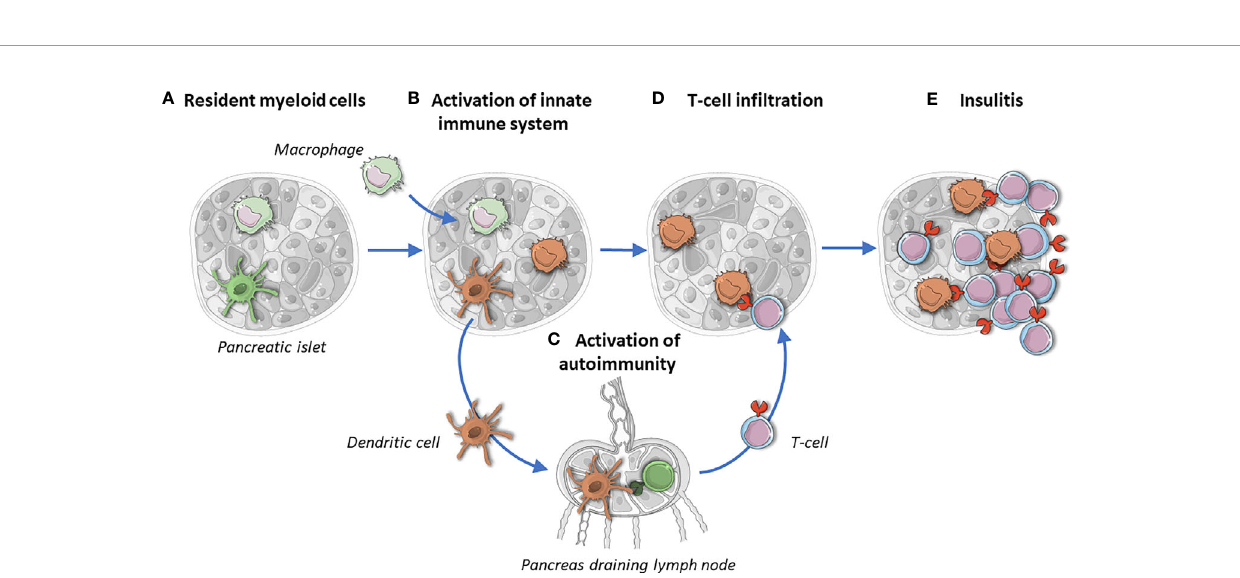
FIGURE 2 | Islets resident myeloid cells maintain tissue homeostasis and protect islets (A) . In T1D, macrophages in fi ltrate islets and their ratio changes toward a pro-in fl ammatory phenotype (B) . Upon activation, islet-resident dendritic cells migrate to pancreatic draining lymph nodes and activate naïve T-cells (C) . Activated T cells in fi ltrate islets and CD4 + T cells scan for islet autoantigens taken up, processed and presented by macrophages and dendritic cells (D) . Insulitic auto-reactive CD8 + T cells target ß-cells (E) . The missing link in (D, E) is the place of the elusive dendritic cells: are they still there, if so, how many and what do they look like? Brown stands for activated myeloid cells.